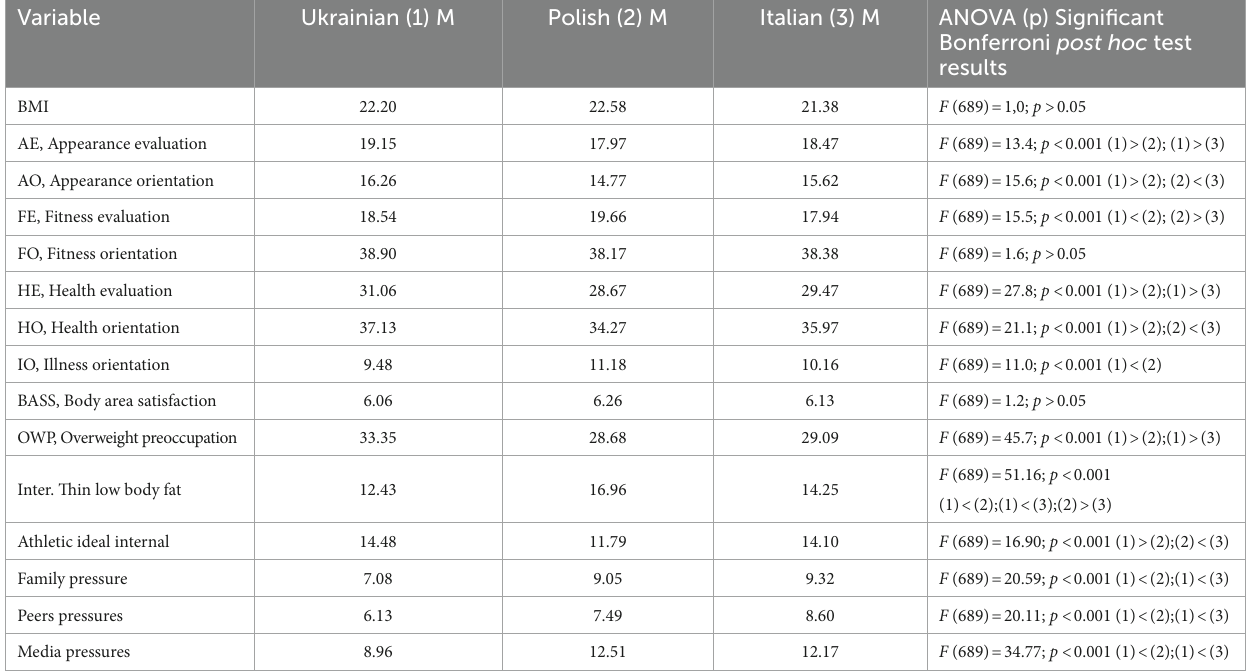
TABLE 4 One-way analysis of the variance of the studied variables for Ukrainian, Polish, and Italian women.